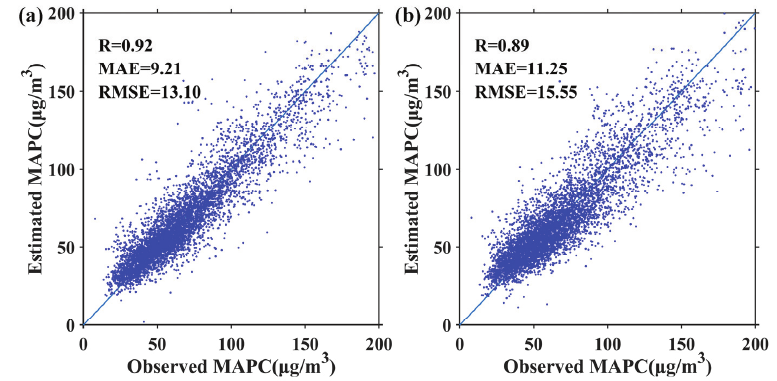
Figure 3. Scatterplots between estimated MAPC and ground observation by using SHM ( a ) and UM ( b ) over the study area during 2015–2017.